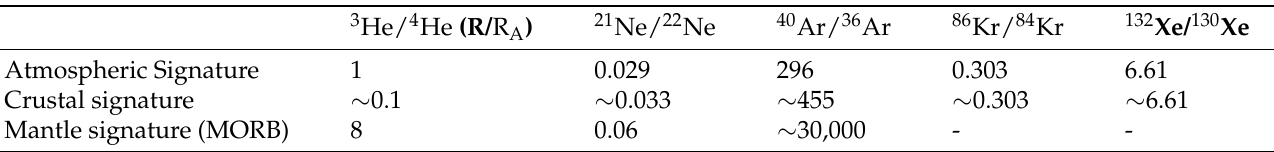
Table 2. Isotopic ratios for the main signatures: atmospheric; crustal, hence radiogenic; and mantle. Atmospheric values from [7]. Natural gas from the Sleipner field [28]. Mantle data from [9]. 3 He/ 4 He (R/ R 21 Ne/ 22 Ne 40 Ar/ 36 Ar 86 Kr/ 84 A )